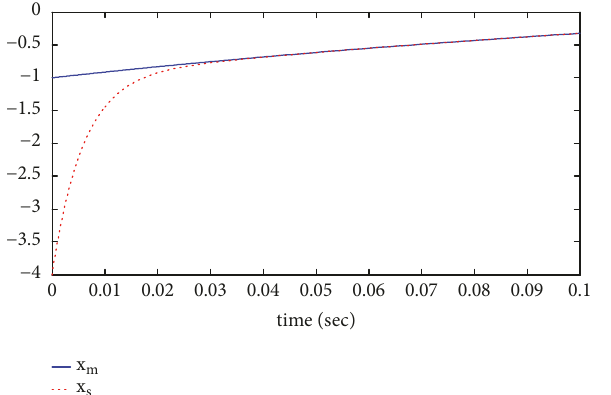
Figure3:Synchronizationprocessbetweenslavestate 𝑥 𝑠 andmaster state 𝑥 𝑚 .